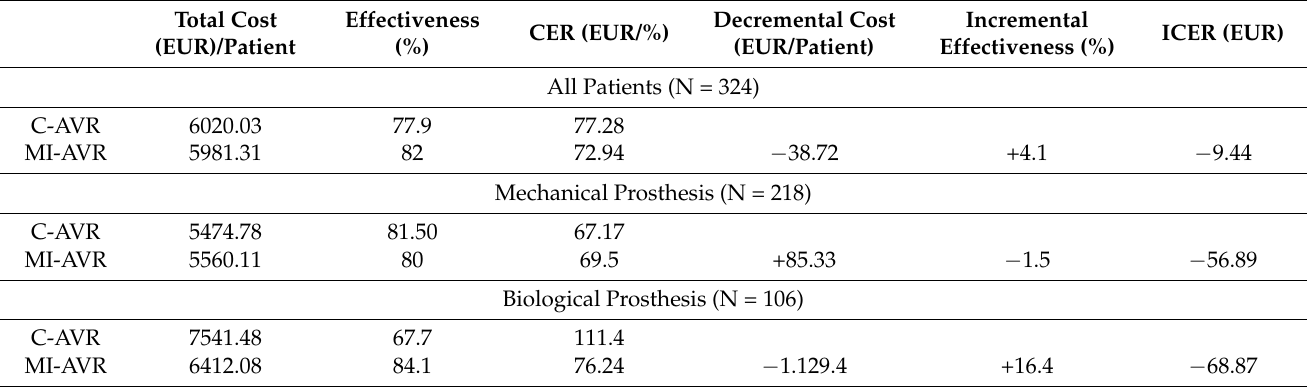
Table 4. Total hospital cost and incremental cost-effectiveness (ICER) of operative AVR protocols.